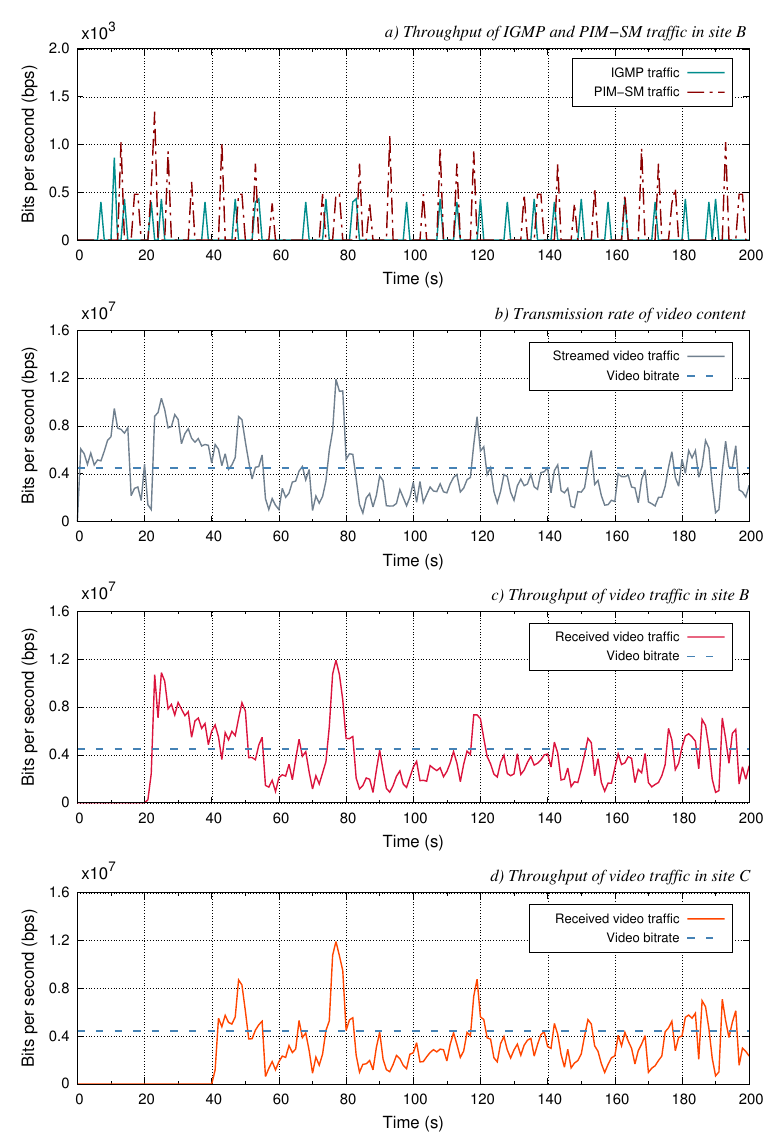
Figure 7. Operation of the IPTV